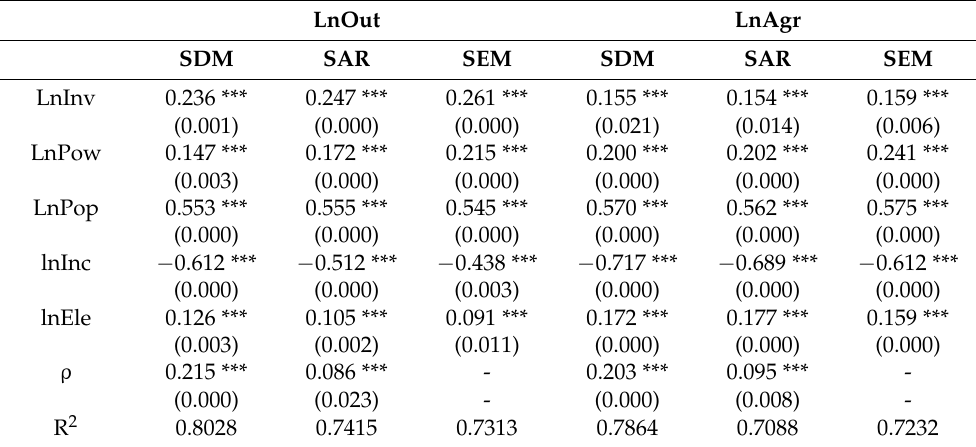
Table 10. Robustness test